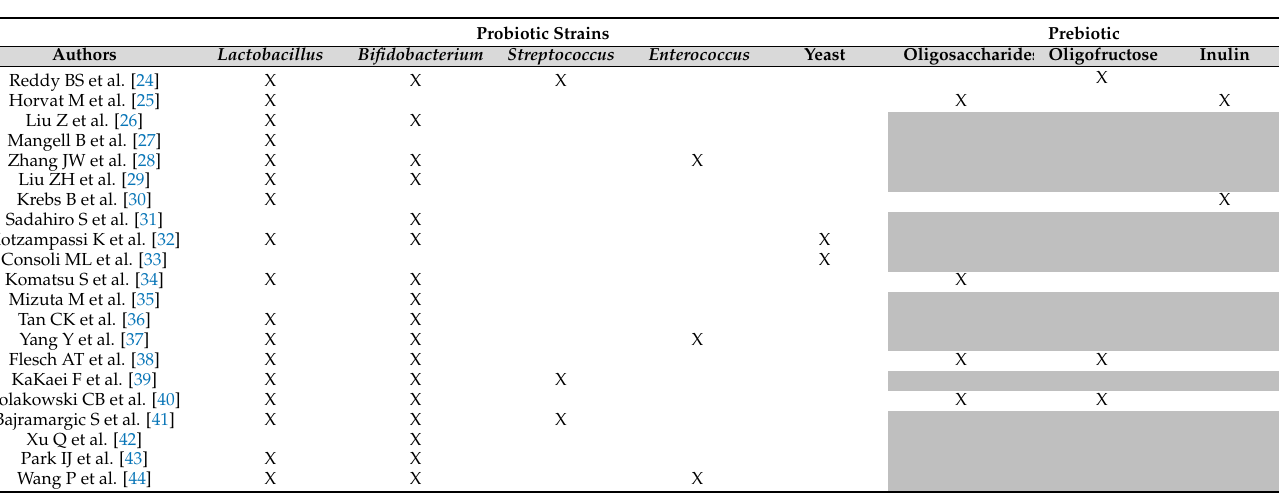
Figure 1. Flow diagram of the search strategy according to PRISMA 2020. Table 2. Details of the strains [24,25,26,27,28,29,30,31,32,33,34,35,36,37,38,39,40,41,42,43,44].